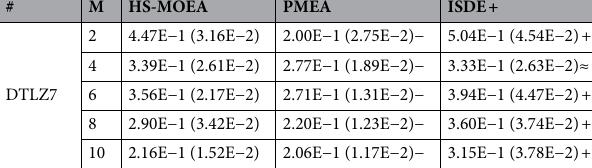
Table 4. Comparison of delta.